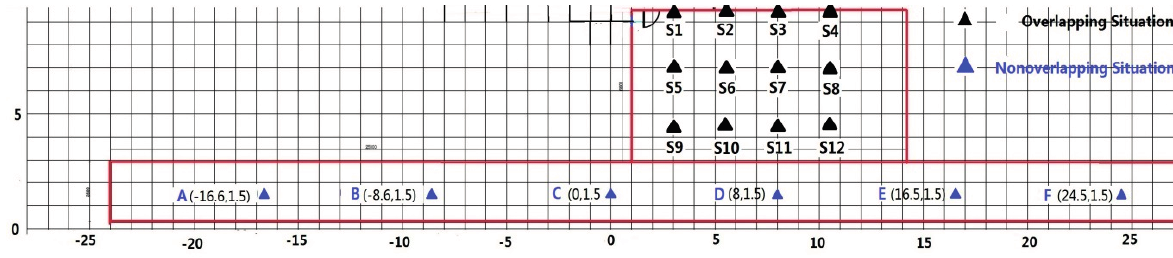
Figure 4. Layout of